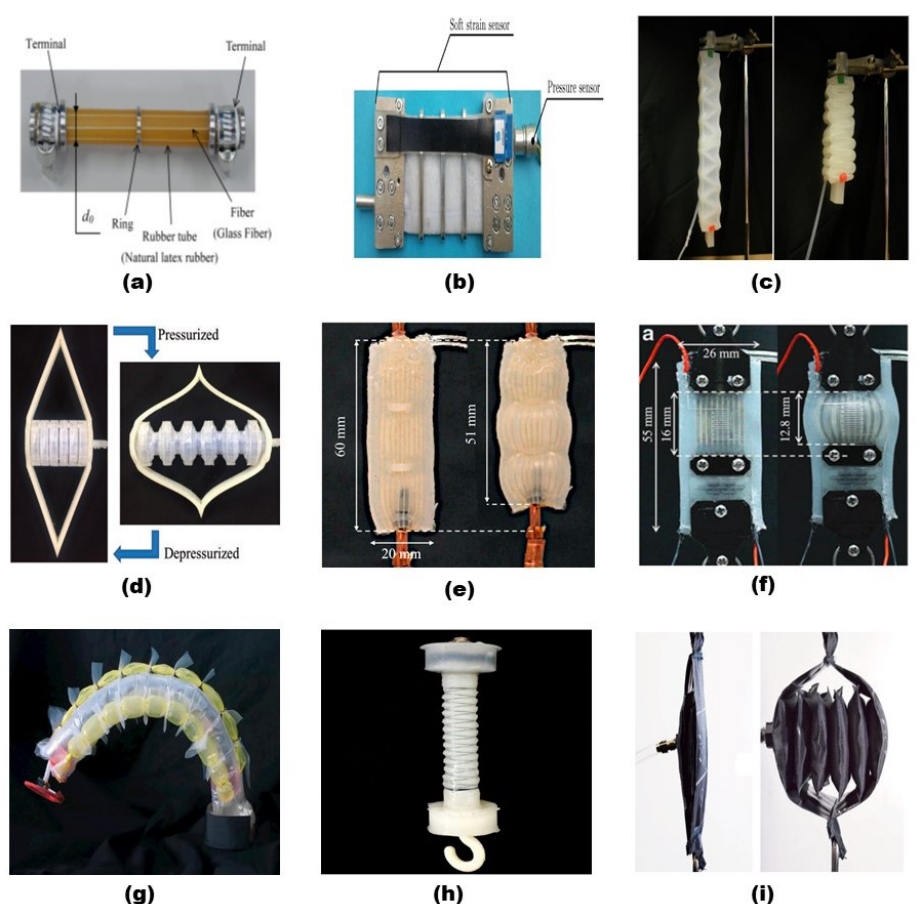
Figure 8. Advanced PAMs: ( a ) Glass fibers reinforced PAM [38]; ( b ) Peano muscle [41]; ( c ) SRM [42]; ( d ) sPAM [37]; ( e ) FPAM [43]; ( f ) sFPAM [44]; ( g ) HCRPAM [45]; ( h ) rPAM [46]; ( i ) High-displacement PAM